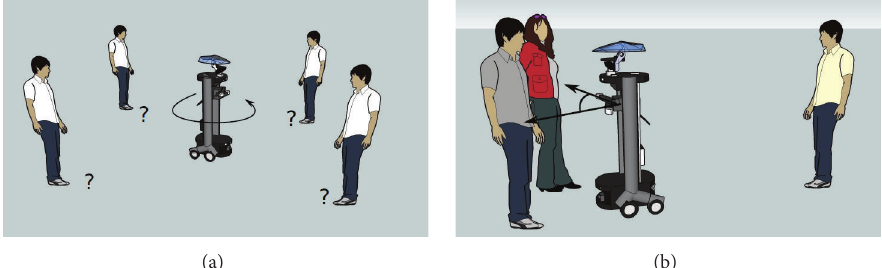
Figure 8: Examples of calls at a distance: unrestricted, one user not at predictable position, and contextualized, multiple users at predictable position.